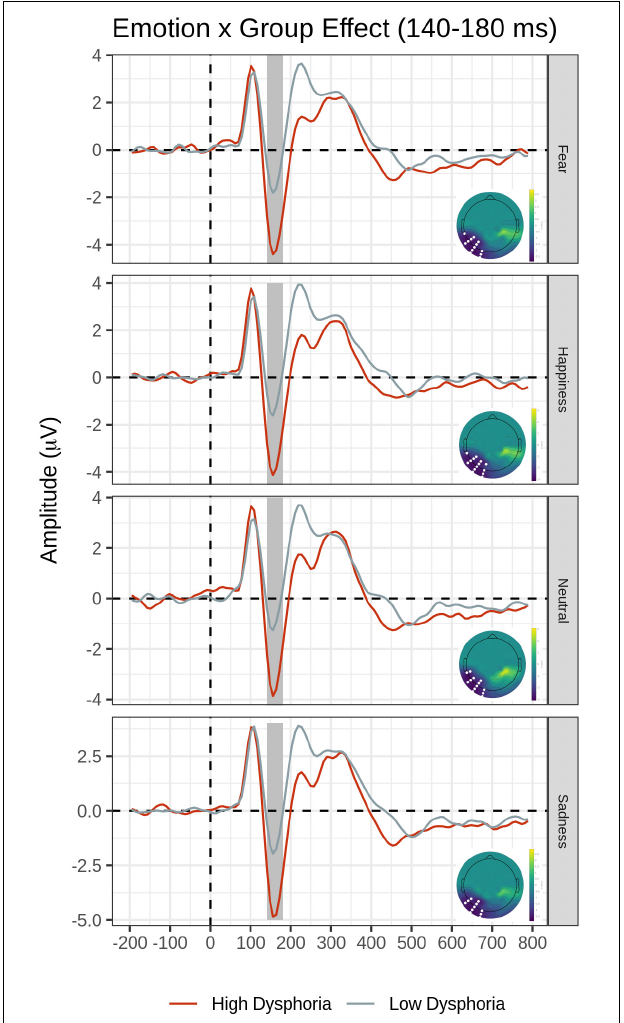
FIGURE 3 | Group × Emotion interaction for the early time window (140–180 ms). In each row, average waveforms of the High and Low dysphoria groups for each emotion and the scalp topography of the significant clusters for the High vs. Low dysphoria group contrast for each emotion (with the significant electrodes highlighted in white). Covert and Overt tasks are